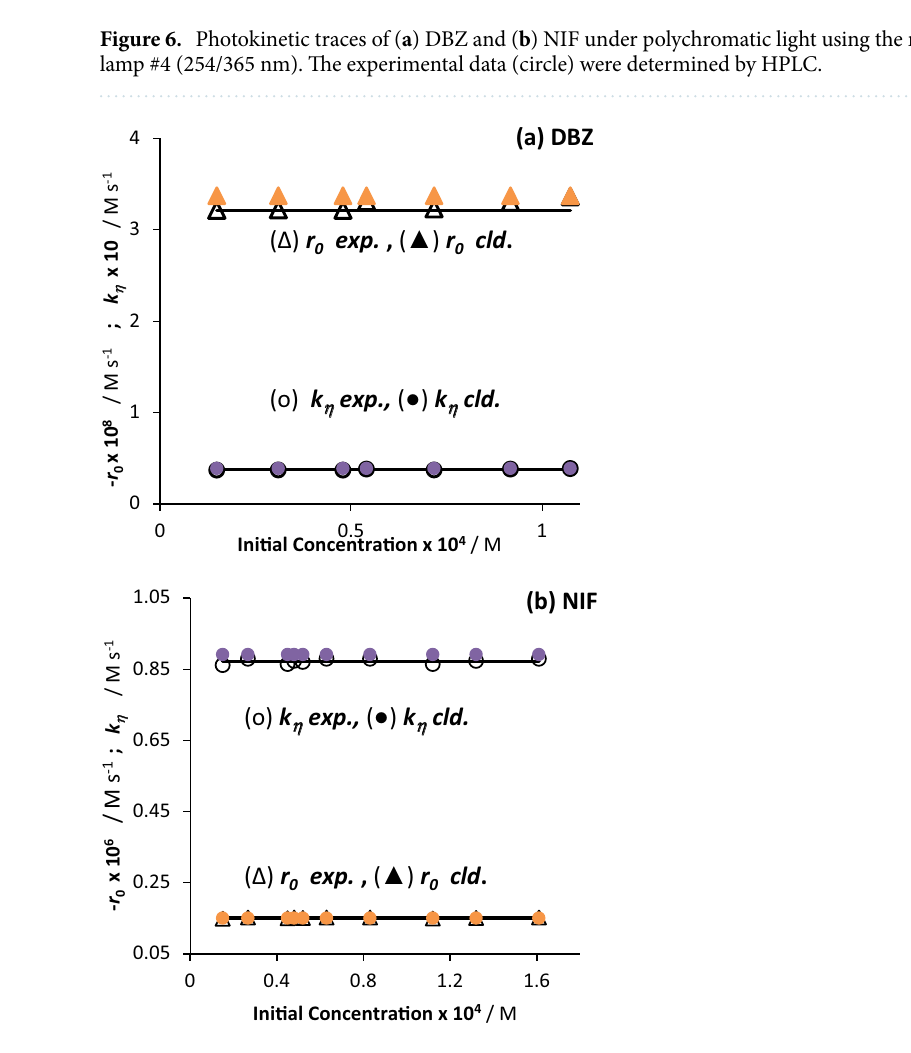
( C A ( 0 )) . η k η ,exp. and r η 0, exp have, respectively, 0, cld . . The